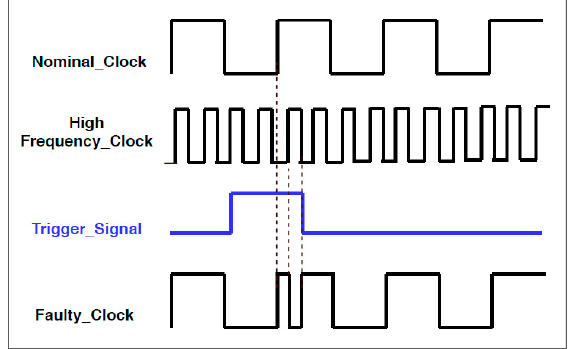
Figure 13. Glitch generation using high-frequency signal [27].